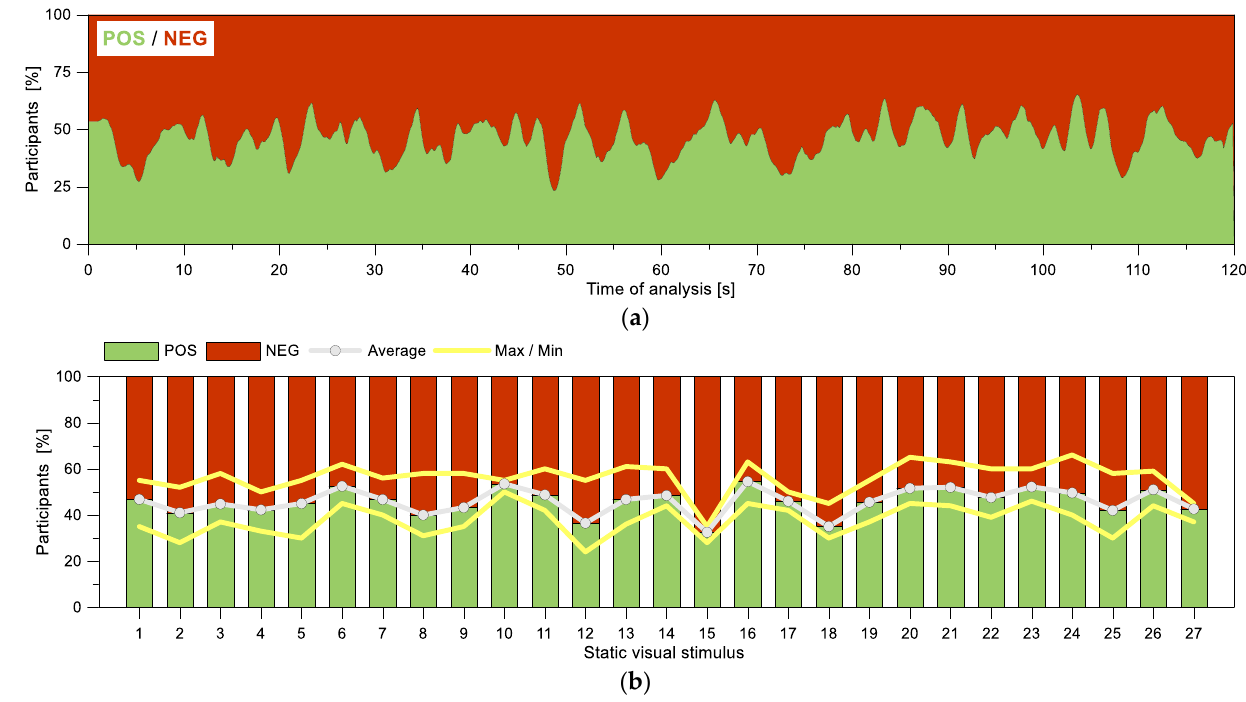
Figure 12. Detection of prevailing reactions (in percentage terms for the group of participants), as a function of ( a ) time of analysis or ( b ) static stimulus (27 pictures).